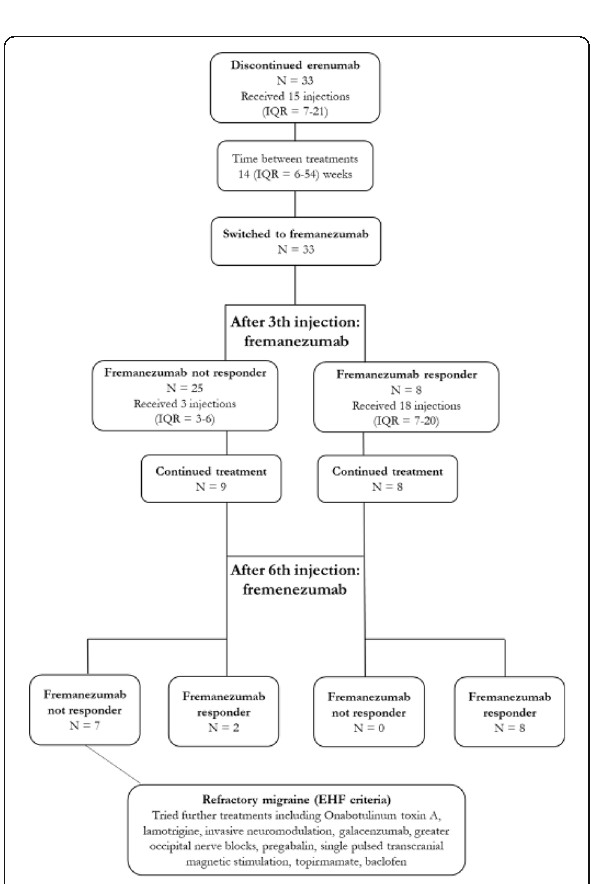
Fig. 1 (abstract A257). Patients ’ pathway with MABS. Number of infections and time between treatments are expressed in